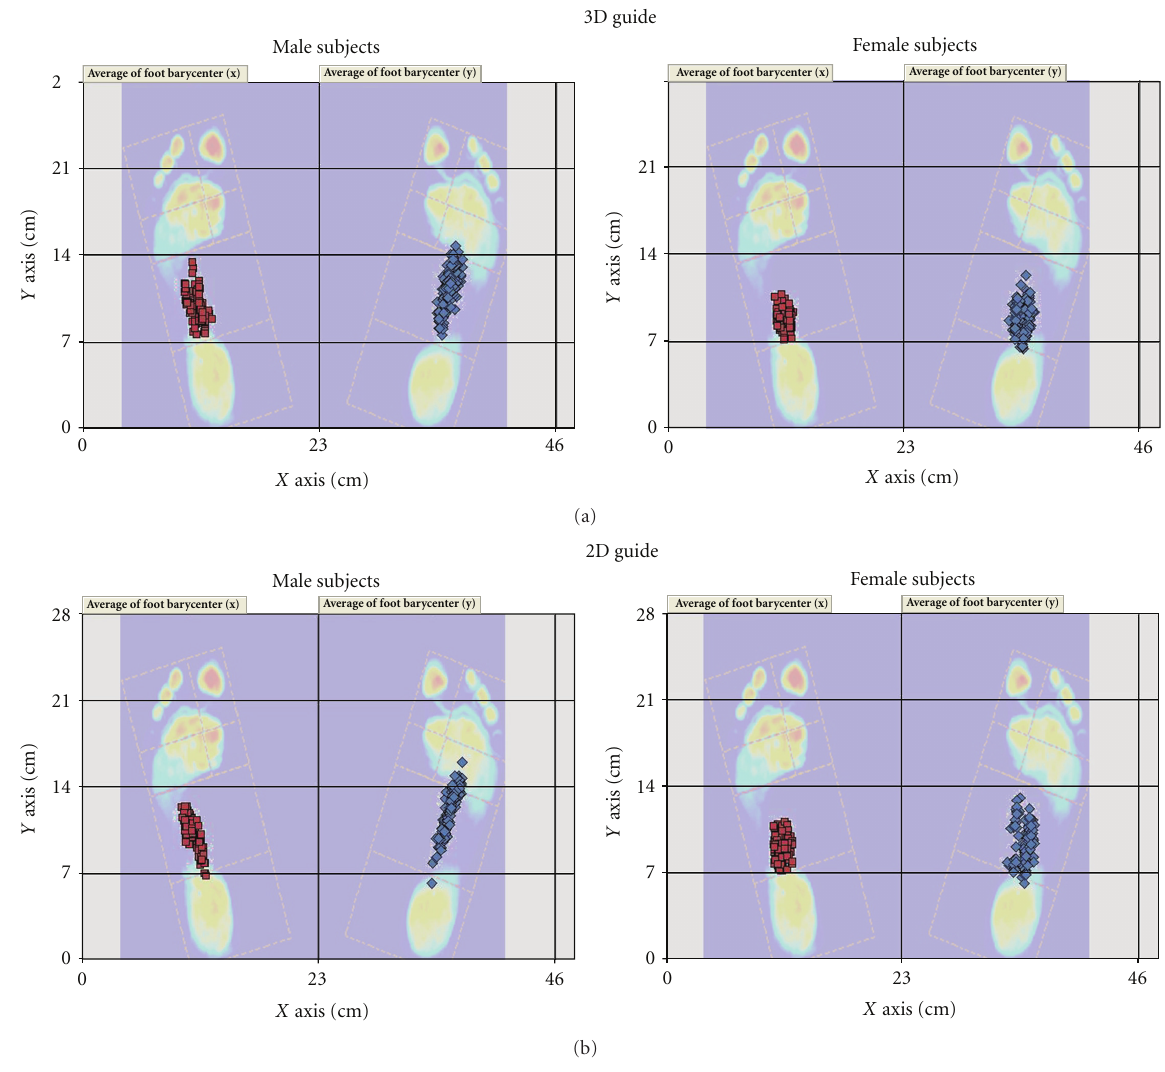
Figure 10: Foot barycenter